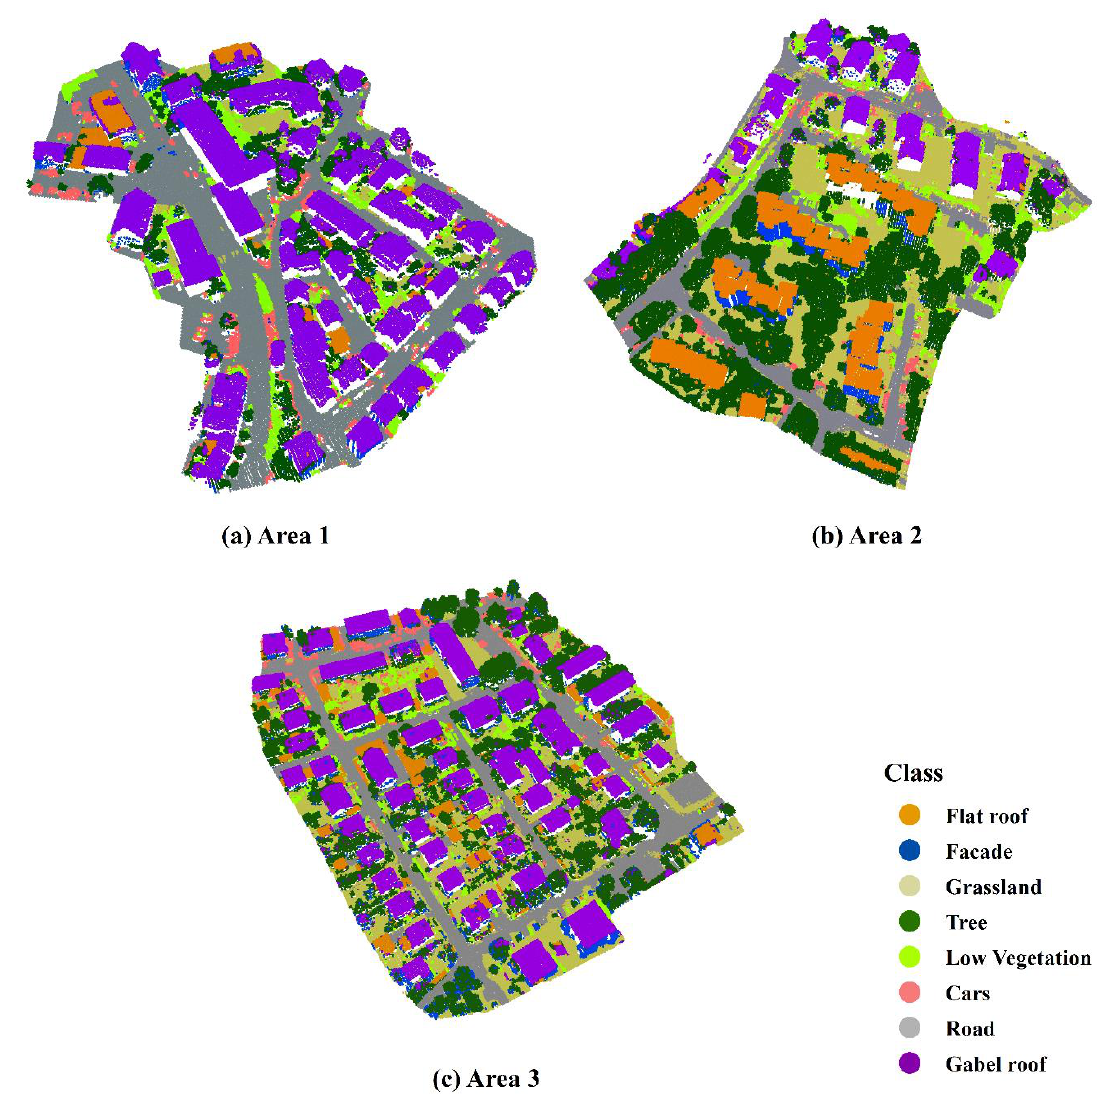
Figure 5. Three-dimensional view of the classification results for the three Vaihingen sites.